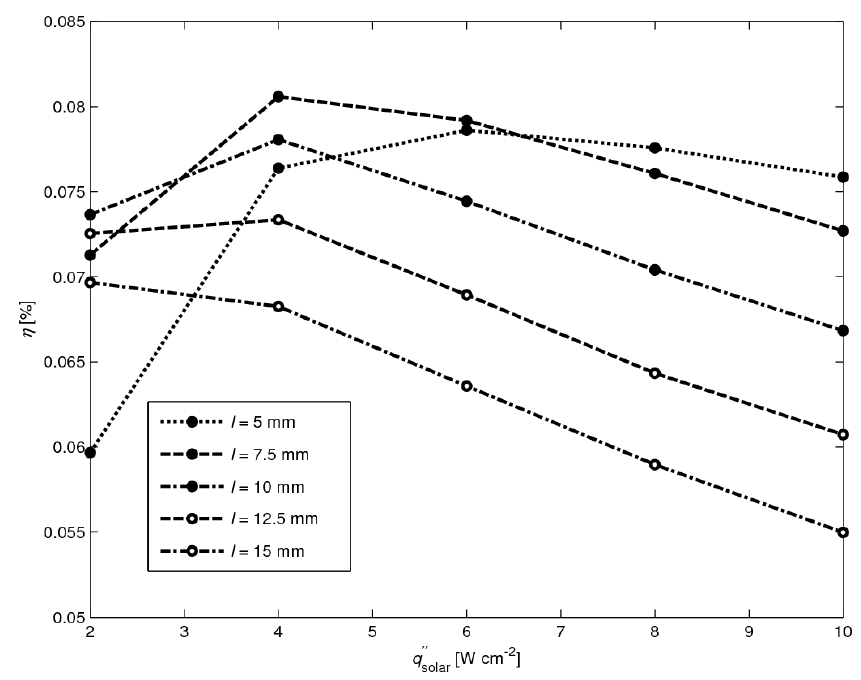
Figure 13. Efficiency as a function of solar radiative flux for l = 5 mm, l = 7.5 mm, l = 10 mm, l = 12.5 mm and l = 15